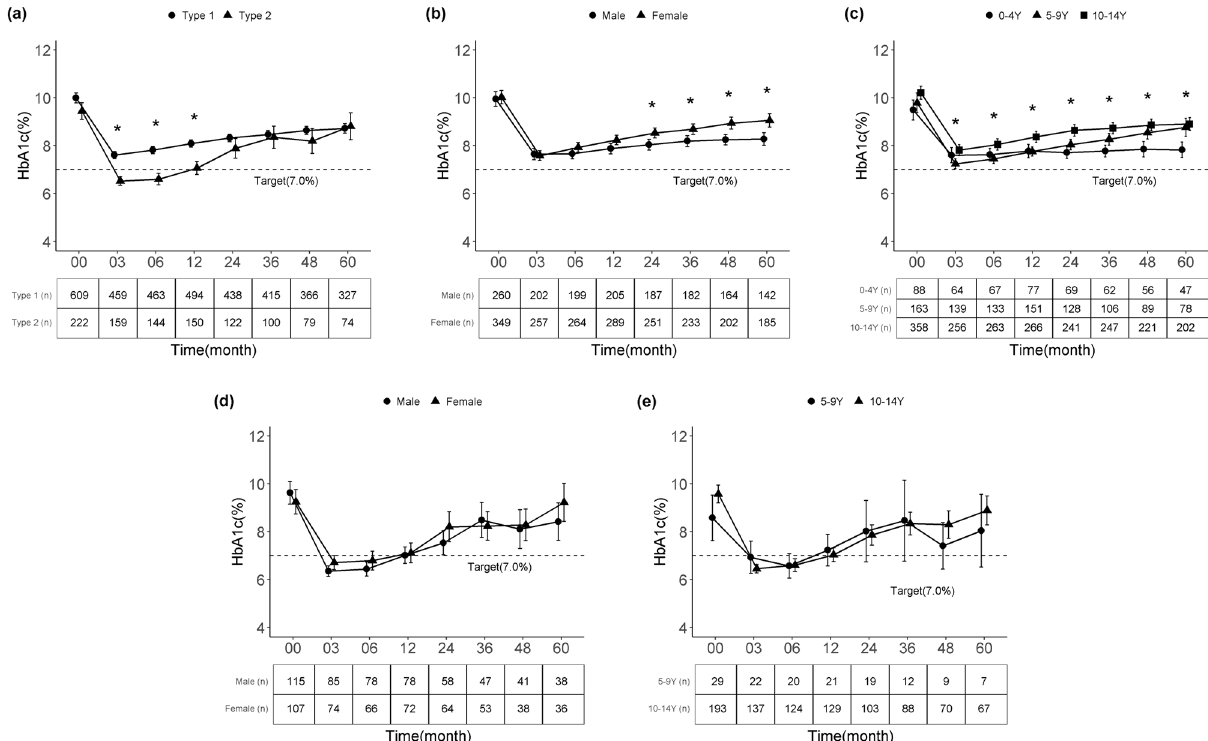
( c ) type 1 diabetes according to age group, ( d ) type 2 diabetes according to sex, and ( e ) type 2 diabetes according to age group. *Bonferroni-corrected p -value <